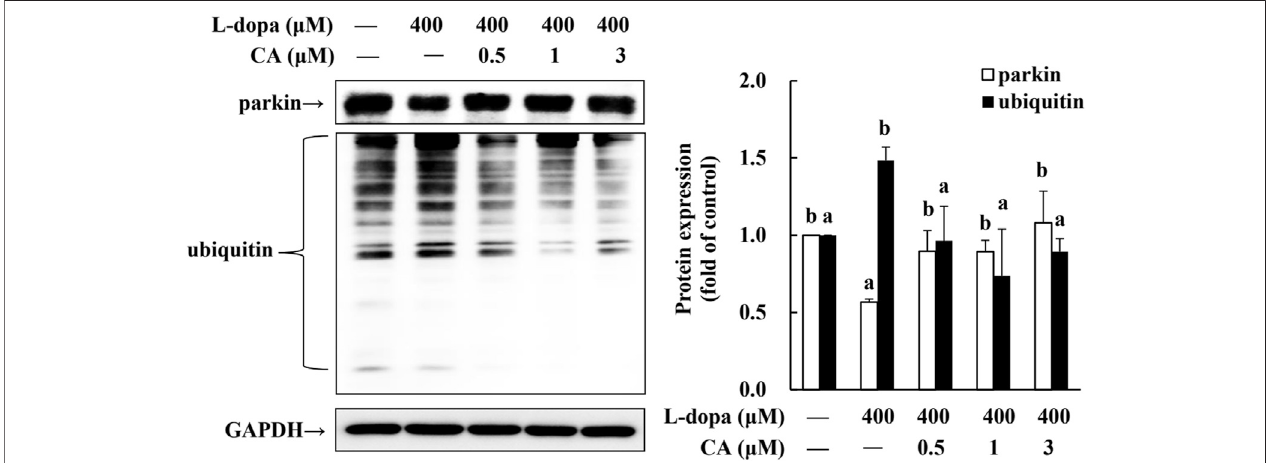
FIGURE 8 | Effect of CA on the expression of parkin and ubiquitinated protein in L -dopa-treated SH-SY5Y cells. Cells were pretreated with DMSO alone ( − ) or 0.5, 1,or3 μ MCAfor18 handwerethentreatedwith400 μ ML-dopaforanadditional24 h.Onerepresentativeimmunoblotoutofthreeindependentexperimentsisshown. The control group was regarded as 1. Values are mean ± SD ( n (cid:1) 3). Means not sharing a common letter are signi fi cantly different, p < 0.05.